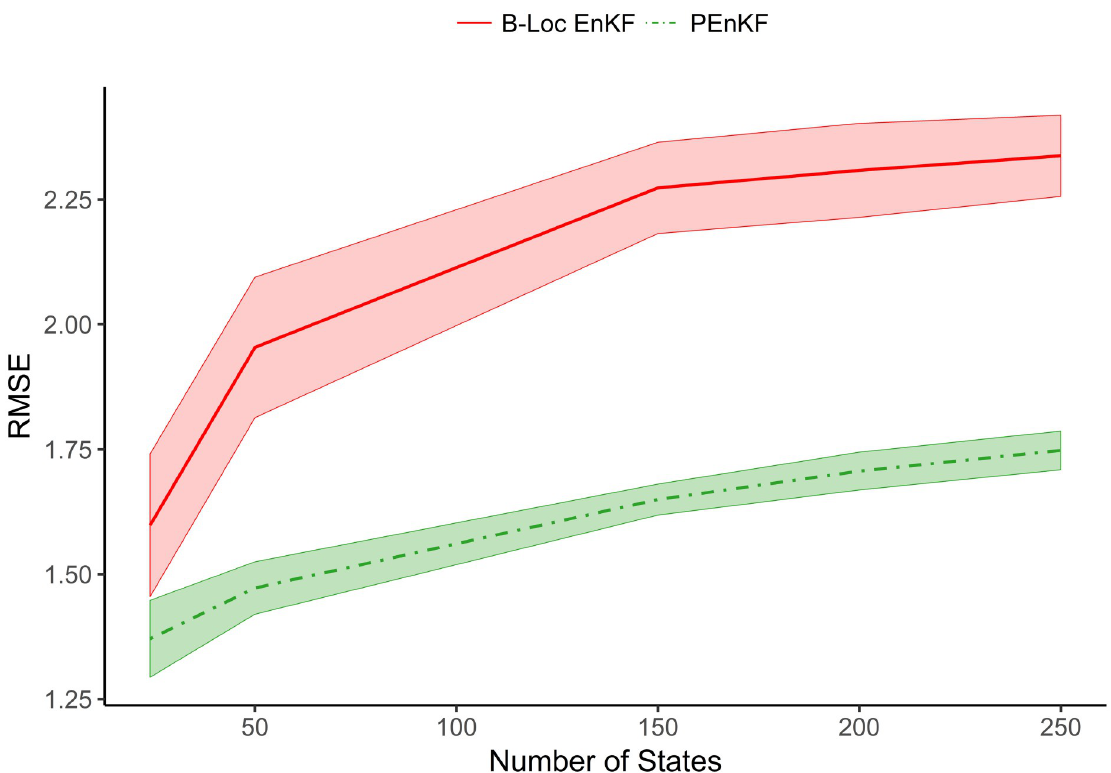
Fig 2. The RMSE of the B-Loc EnKF and PEnKF over 50 trials using 25 ensemble members. The darker lines of each linetype are the mean and the colored areas are the 95% confidence intervals. There is clear separation between the RMSE of the two filters with the PEnKF’s error being significantly